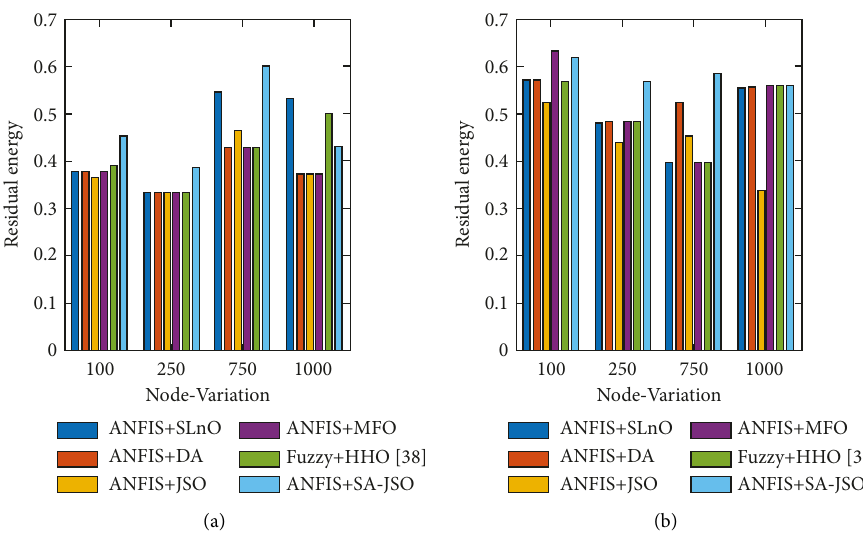
Figure 9: Analysis of residual energy for developed approach over compared approaches regarding (a) group 1 and (b)